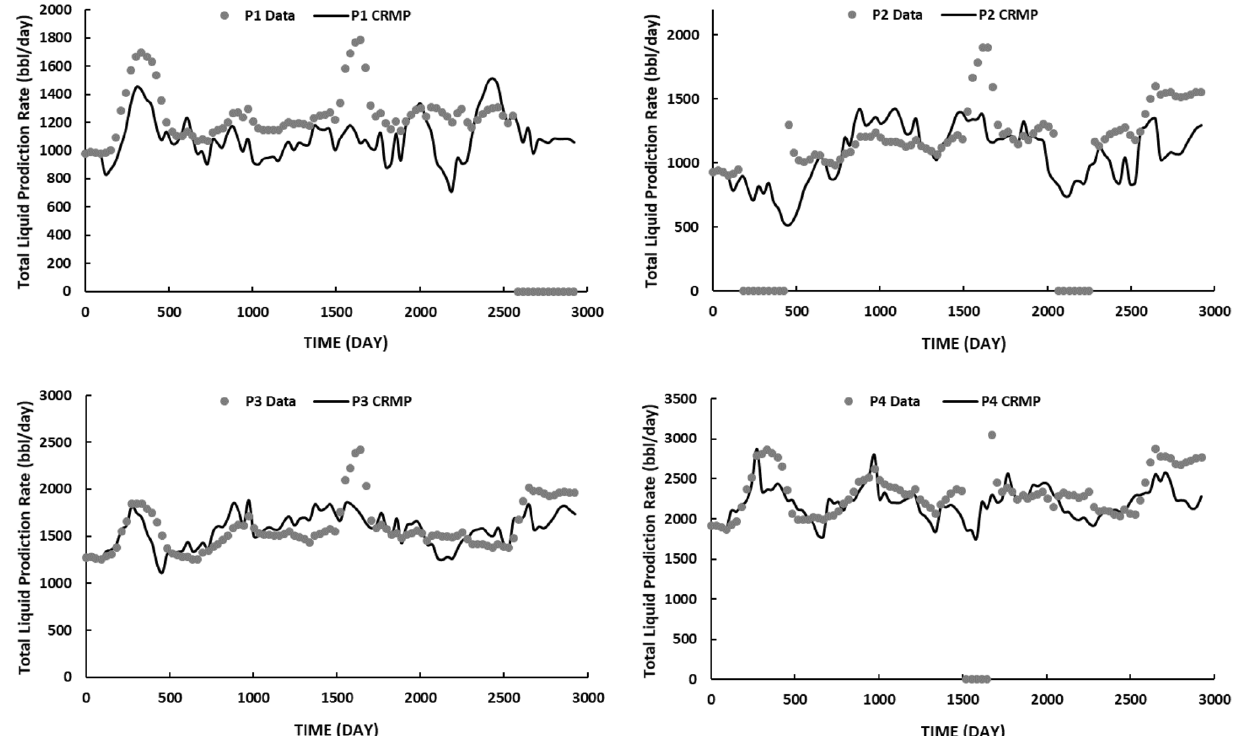
Fig. 11 Liquid production rates match by CRMP in case II